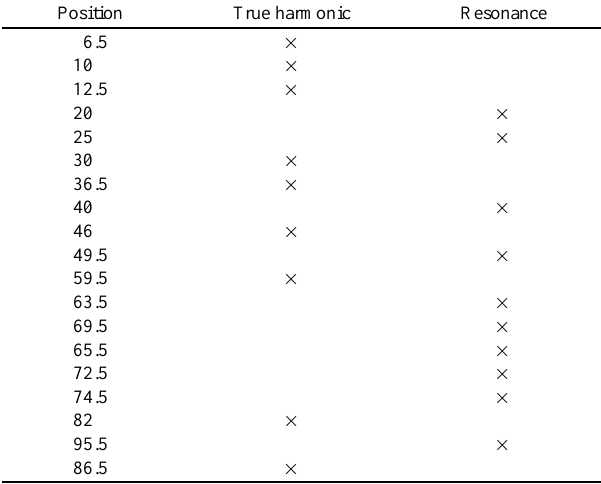
Table 1 Characterisation of the greatest identified peaks in the range [0 ; 100